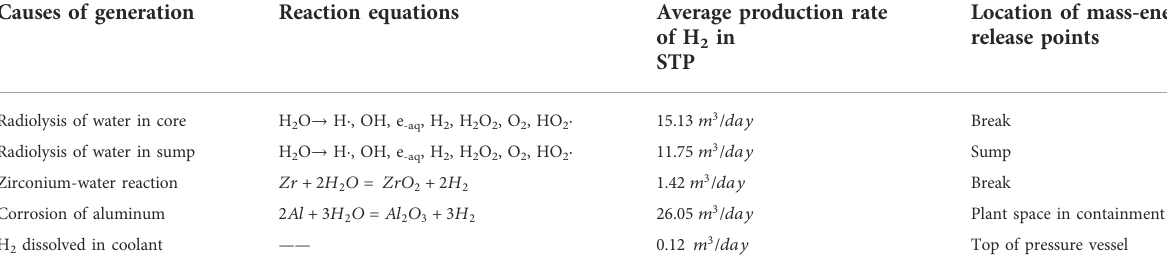
TABLE 2 Hydrogen production during LBLOCA accident (Ershov and Gordeev, 2008). Causes of generation Reaction equations